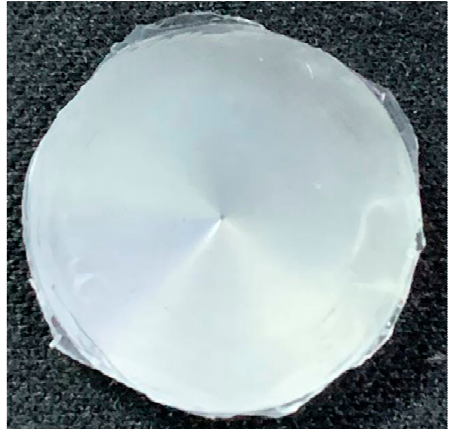
Figure 12. PDMS material with microstructure.